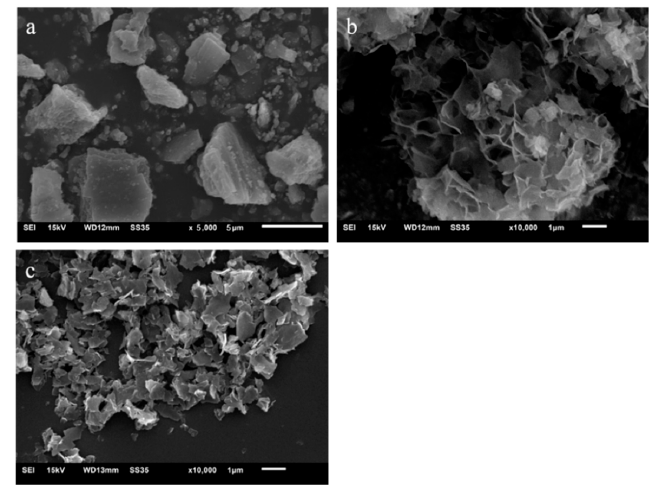
Figure 4. Scanning electron images. ( a ) mussel shells powder; ( b ) CCNPs-1; ( c ) CCNPs-2